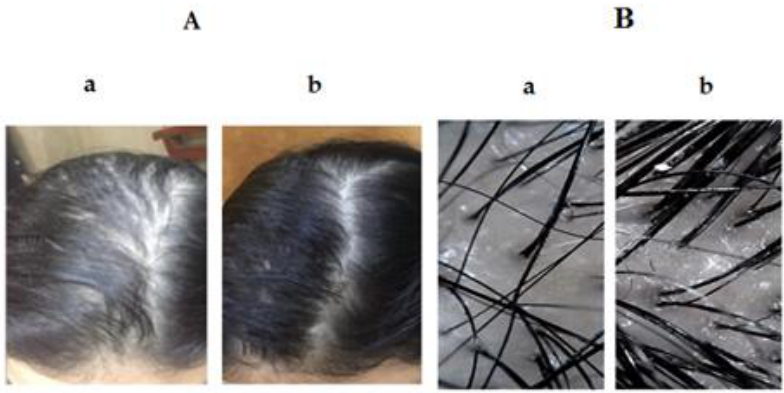
Figure 11. Clinical photographs ( A ), dermoscopic pictures ( B ) of group A; pre-treatment ( a ) and Post-treatment ( b ) with SV-loaded SNVs. Abbreviations: SV, Sodium valproate; SNVs, spanlastic nanovesicles.